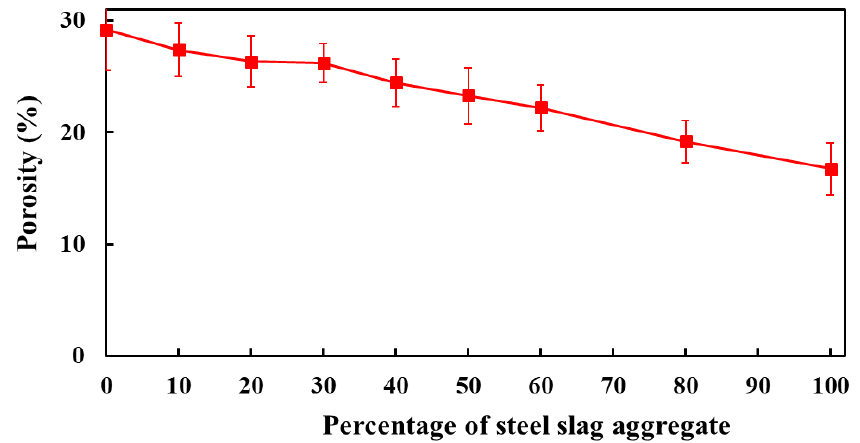
Figure 10. Porosity of concrete made with different percentages of IFSSA.